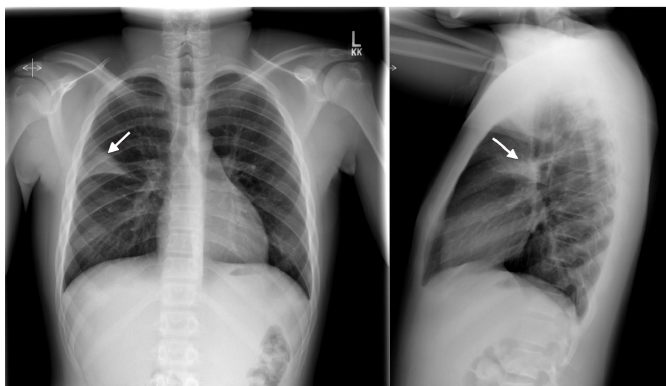
Figure 2. Anterior-Posterior chest radiograph on day 6 showing consolidation of the inferior segment of the right upper lobe